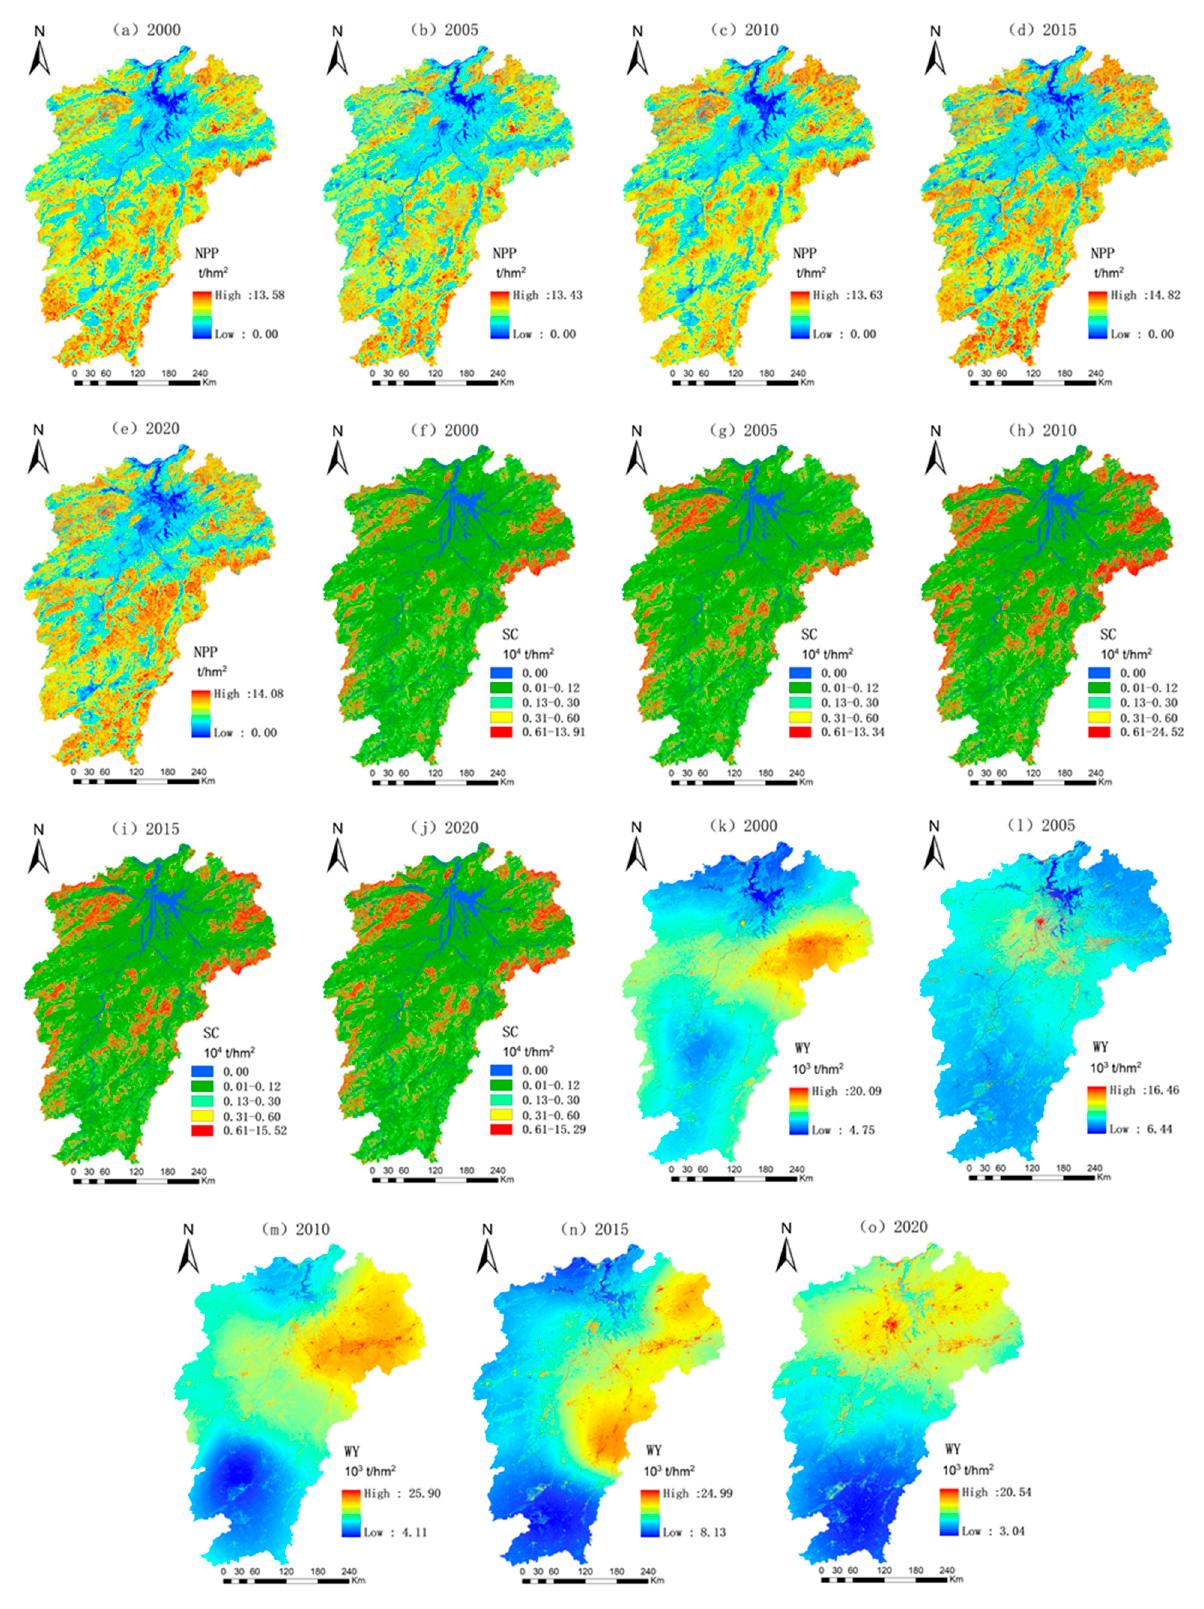
Figure 3. The spatial distribution of ecosystem services from 2000 to 2020 in Jiangxi Province: ( a – e ) NPP; ( f – j ) SC; ( k – o ) WY.